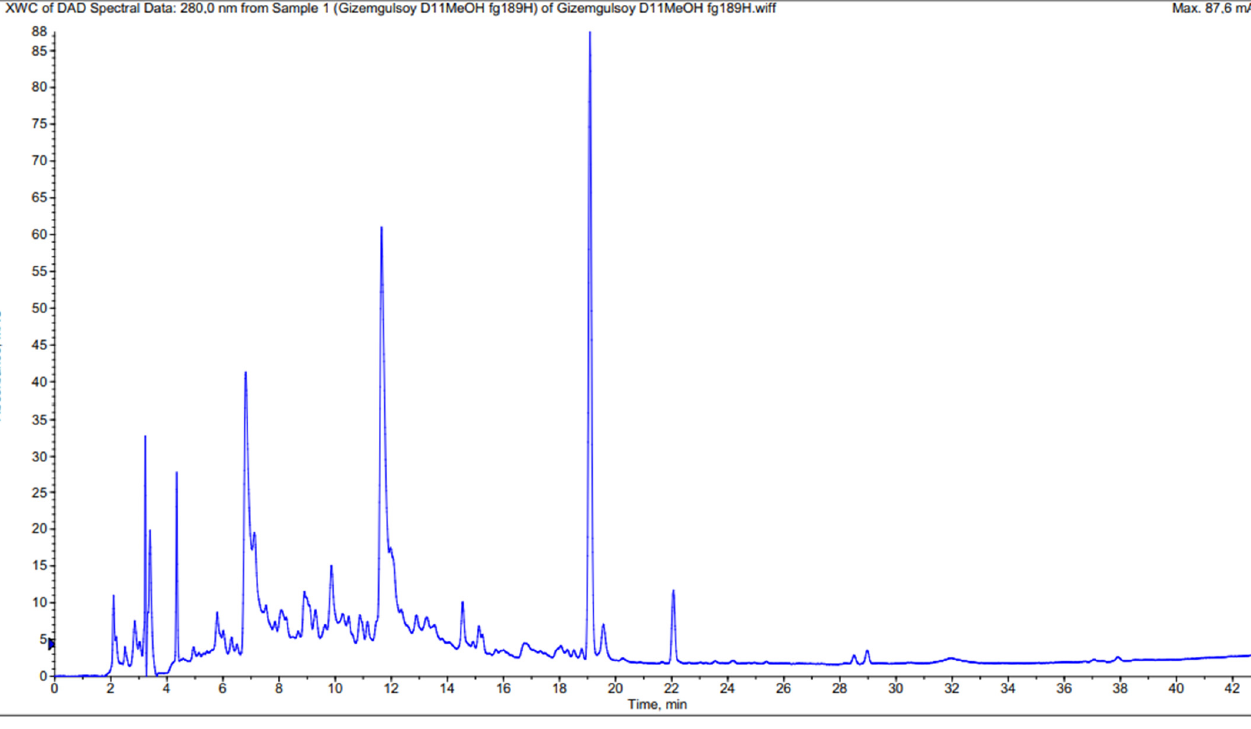
Figure 1. HPLC chromatogram of methanolic extract from A. biebersteinii .